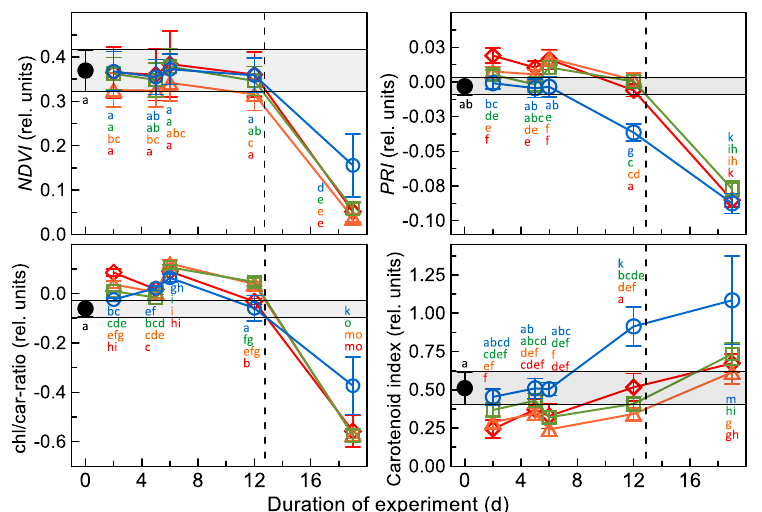
Figure 6. Means ( ± SD, n = 6) of the normalized difference vegetation index (NDVI), the photo- chemical reflectance index (PRI), the chlorophyll to carotenoid ratio, and the carotenoid index of banana fruit measured during cold storage ( circles: 5 ◦ C; (cid:3) squares: 10 ◦ C; ∆ triangles: 11.5 ◦ C; (cid:35) diamonds: 13 ◦ C) and shelf life. The vertical dashed line indicates the end of cold storage on day 12 (cid:51) of the experiment. The filled circles reflect the means (the grey horizontal bar shows the respective SD) of all bananas ( n = 76), measured before storage. Different small letters indicate significant ( p < 0.05) differences between